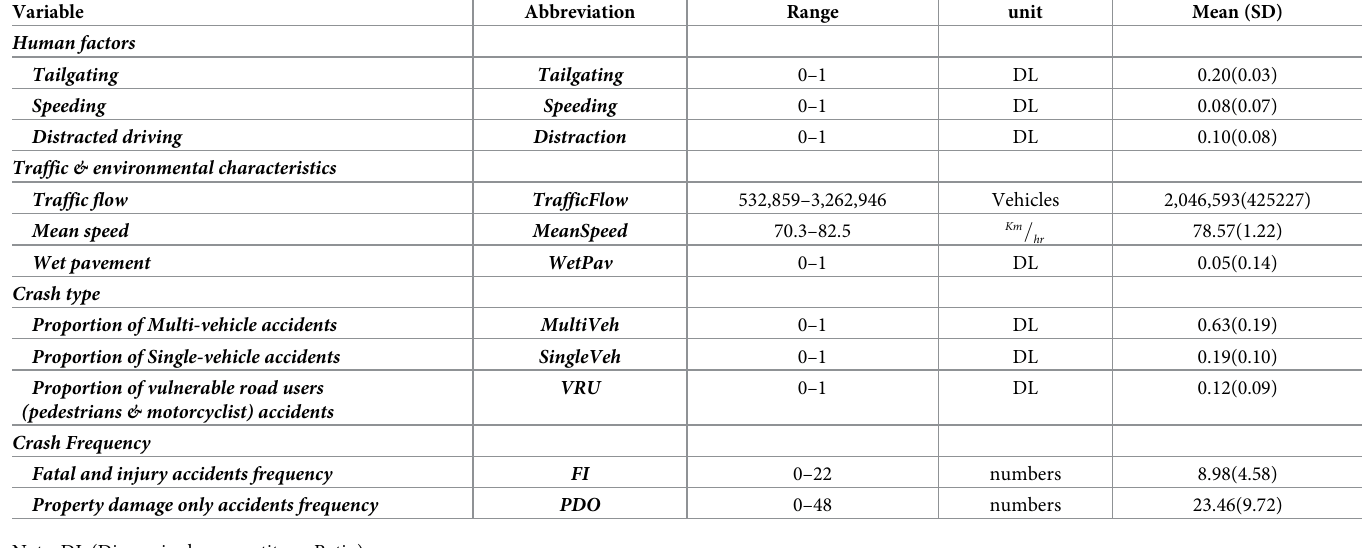
Table 2. Descriptive statistics of